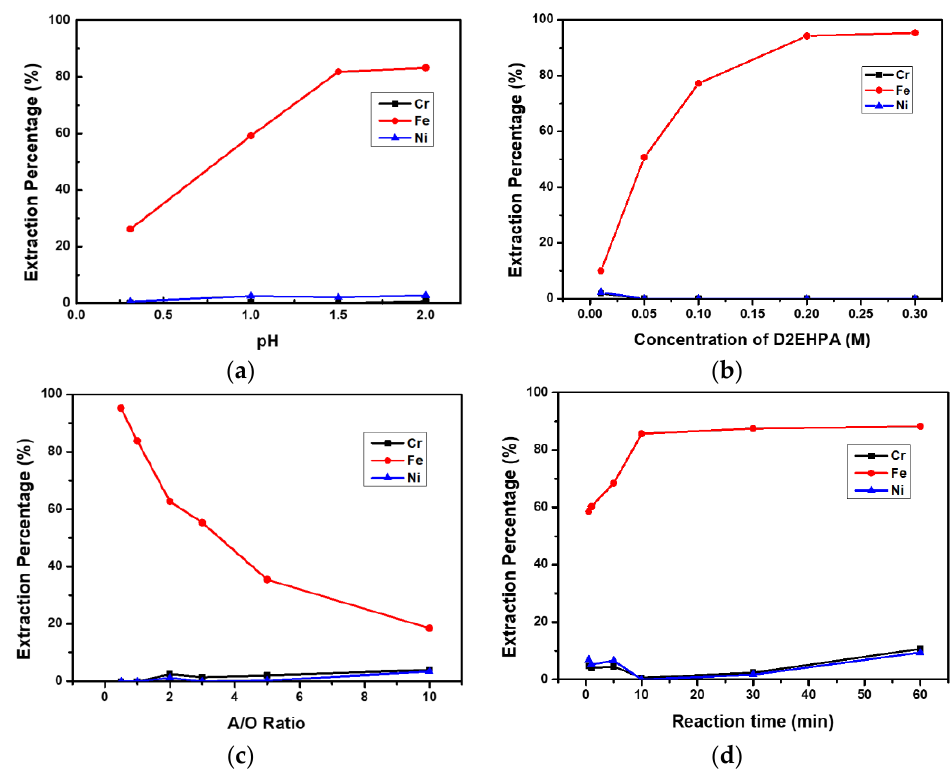
Figure 5. ( a ) Effect of the extraction percentage on pH value. ( b ) Effect of the extraction percentage on D2EHPA concentration. ( c ) Effect of the extraction percentage on aqueous-organic ratio. ( d ) Effect of the extraction percentage on reaction time.